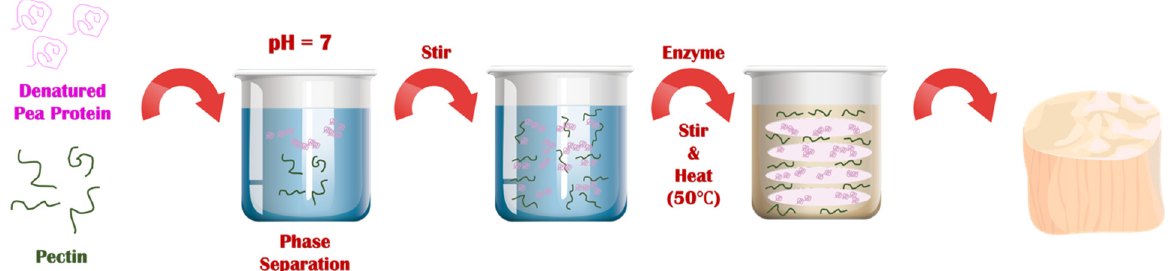
Figure 2. Scallop analogs can be formed through controlled phase separation, shearing, and gelling of mixtures of heat-denatured pea proteins and pectin.